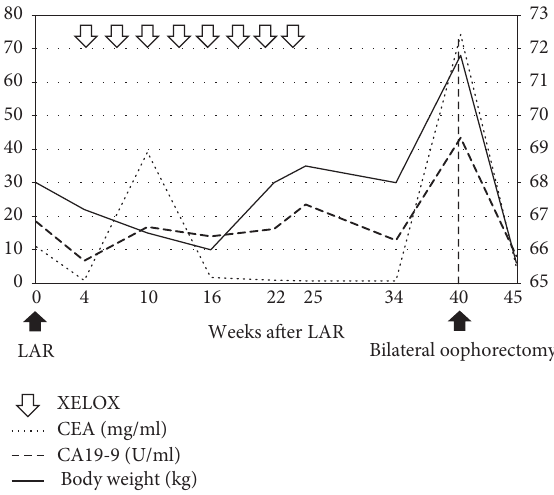
Figure 7: Changes in serum levels of tumor markers and body weight after primary colectomy and chemotherapy in case 3. LAR, lower anterior resection; XELOX, capecitabine and